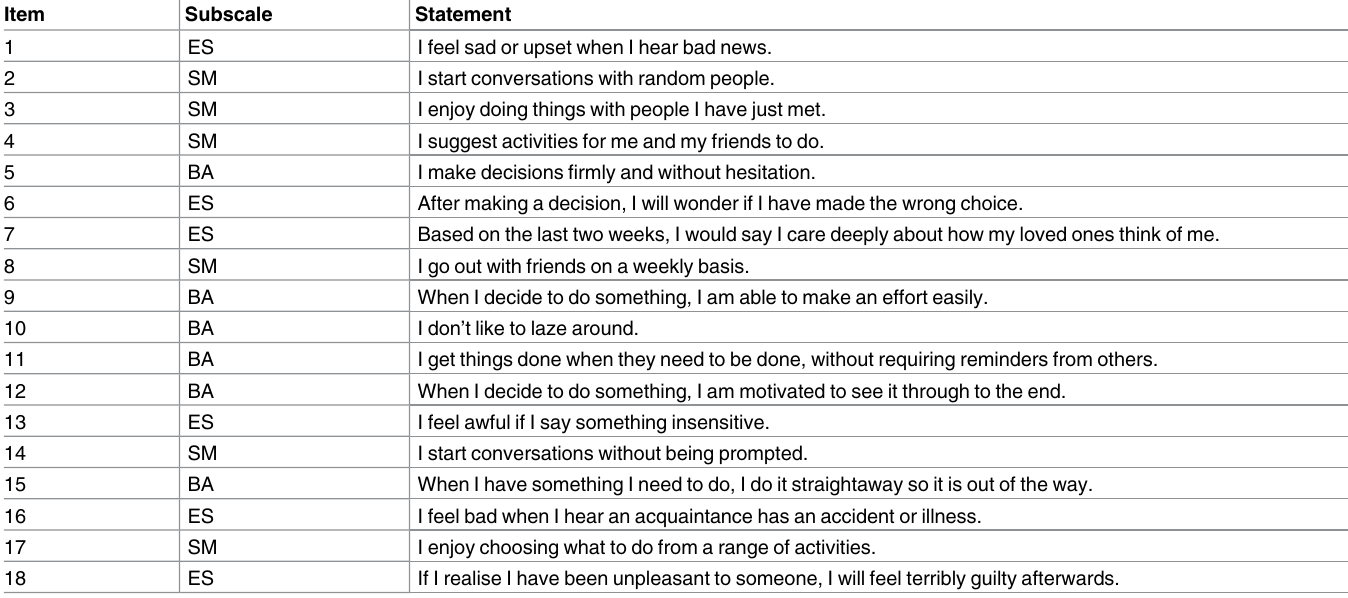
Table 1. Apathy-Motivation Index (AMI, provided in S1